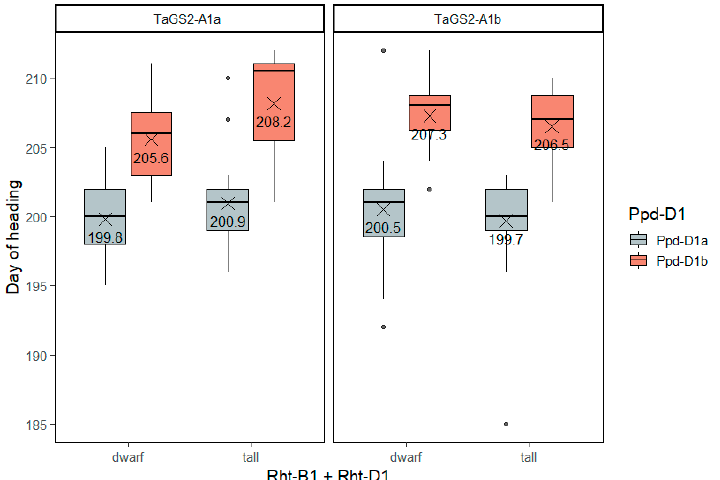
Figure 3. The heading date (days from sowing) of winter wheat accessions differing in genotypes of the three groups of genes— Rht-B1 + Rht-D1 , Ppd-D1 , TaGS2-A1 . The so-called ‘tall’ accessions are those that have both Rht-B1a and Rht-D1a wild-type alleles, while ‘dwarf’ ones are those possessing either Rht-B1b , Rht-B1e or Rht-D1b alleles. The dots indicate outliers.